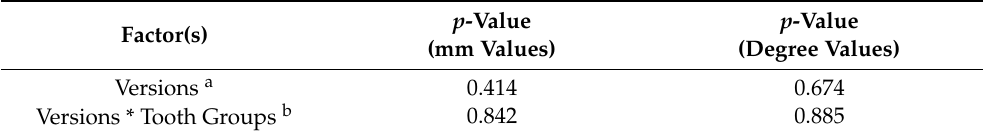
Table 3. A mixed model calculated the p -values to detect whether one factor or an interaction of two factors significantly influenced the positions of brackets in linear (mm values) and angular (degree axis)